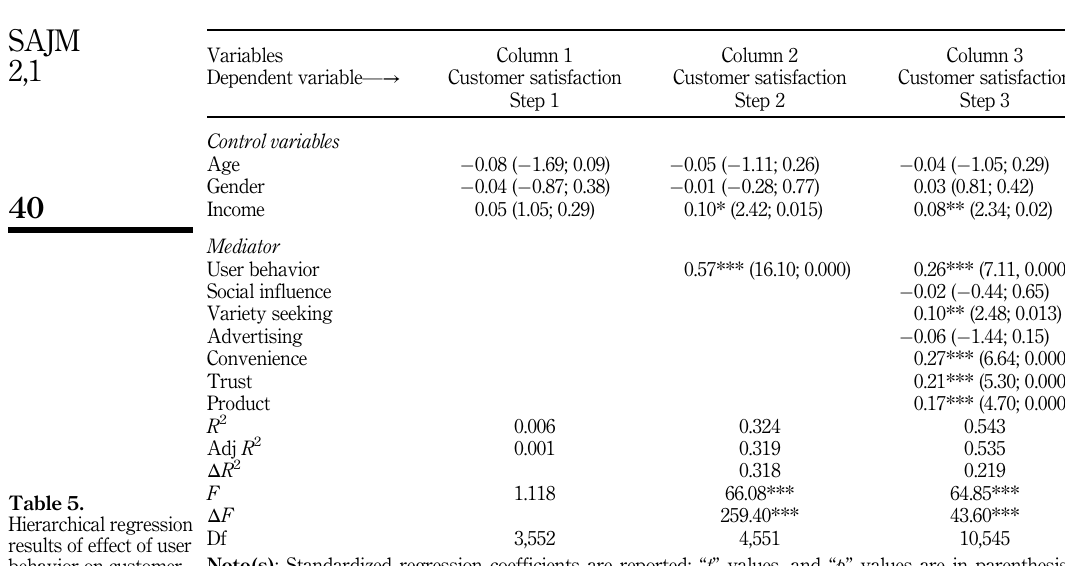
Table 5. Hierarchical regression results of effect of user behavior on customer